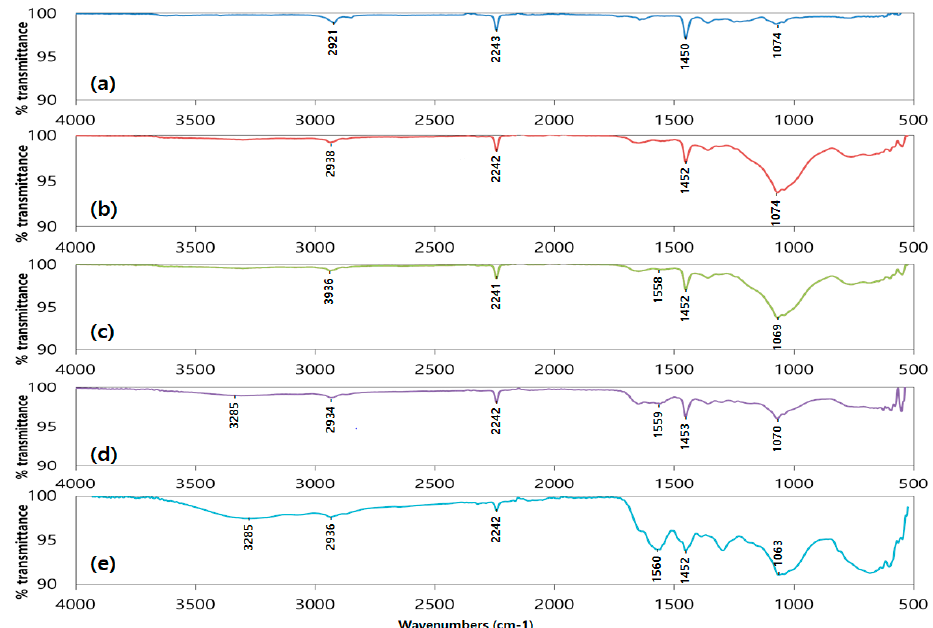
Figure 3. Fourier-transform infrared spectroscopy (FTIR) spectra of ( a ) unmodified PAN fiber and PAN fiber with different concentration of DETA: ( b ) 40% DETA, ( c ) 55% DETA, ( d ) 70% DETA, and ( e ) 85% DETA.